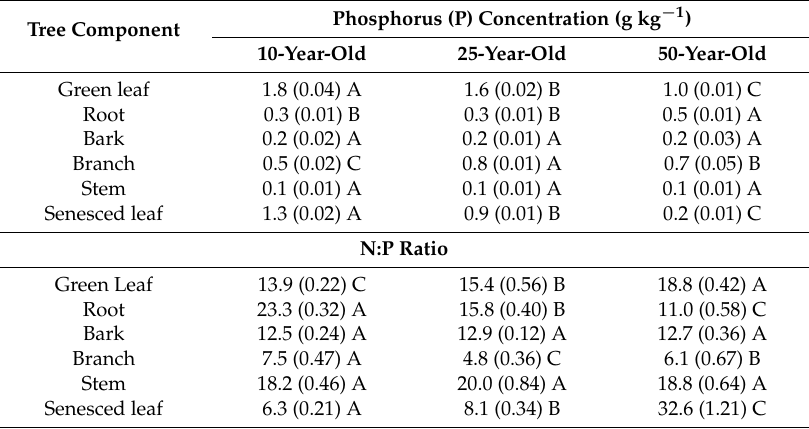
Table 2. P concentrations and N:P ratio in different larch-plantation